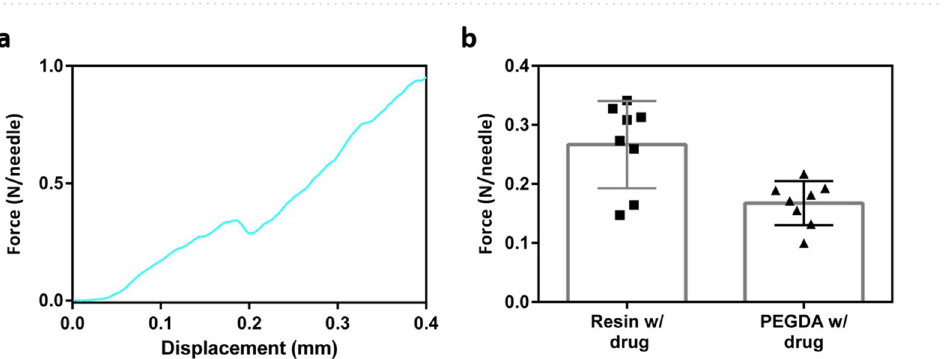
Figure 6. ( a ) Mechanical behavior of an individual microneedle containing drug and resin, ( b ) comparing the robustness of resin/drug microneedle with PEGDA/drug